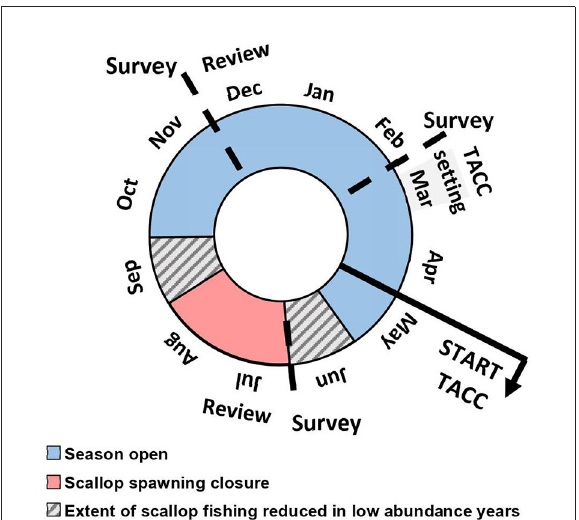
FIGURE2 Schematic of the annual management cycle and fishing season for Shark Bay. Surveys conducted to provide information for TACC setting and within-season reviews are also